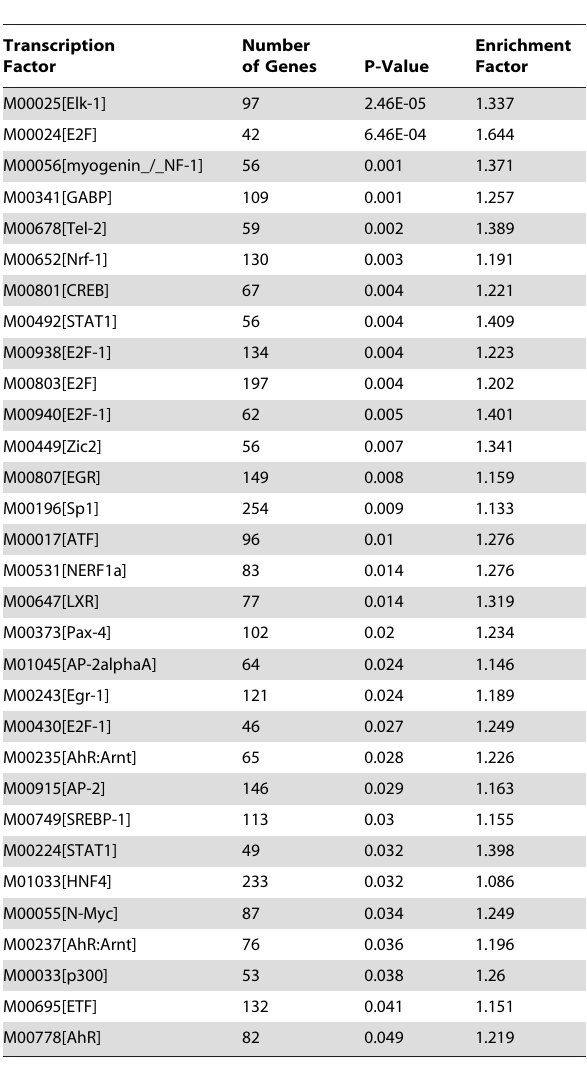
Table 4. Transcription factor binding sites enriched in gene promoters of differentially expressed mRNAs in PND70 mice.